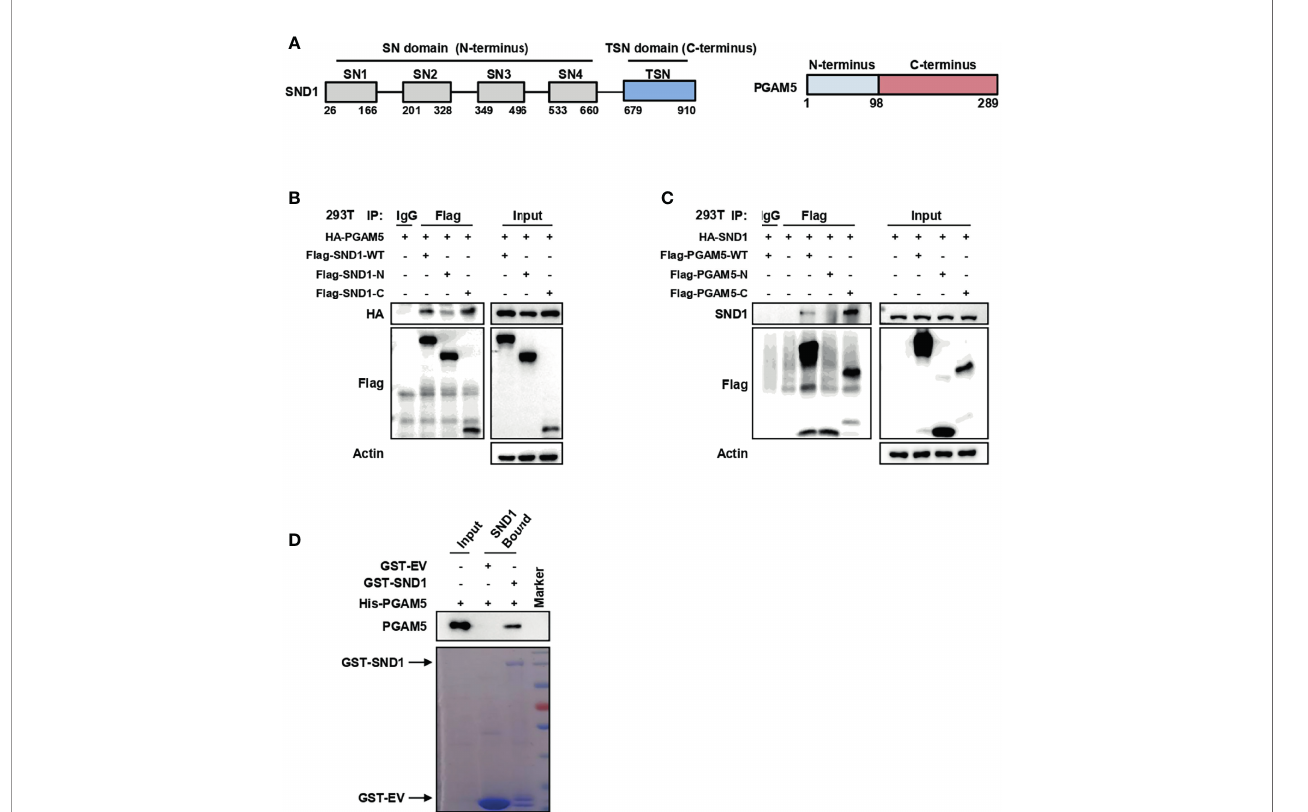
FIGURE 4 | The C-termini of both SND1 and PGAM5 mediate the binding of SND1 and PGAM5. (A) The diagrams show the structures of SND1 and PGAM5. (B) 293T cells were transfected with HA-PGAM5 plasmids alone or together with Flag-tagged plasmids expressing full-length SND1 (WT), its SN domains (N-terminus) or the TSN domain (C-terminus). Cell lysates were immunoprecipitated with anti-Flag antibody or IgG, followed by immunoblotting analysis with antibodies against HA and Flag. Actin served as loading control. (C) 293T cells were transfected with HA-SND1 plasmids alone or together with Flag-tagged plasmids expressing full-length PGAM5 (WT), the N-terminus, or the C-terminus. Cell lysates were immunoprecipitated with anti-Flag antibody or IgG, followed by immunoblotting analysis with antibodies against SND1 and Flag. Actin served as loading control. (D) GST pull-down of His-PGAM5 by GST-SND1 using protein puri fi ed from E. coli , followed by immunoblotting analysis with anti-PGAM5 and anti-GST